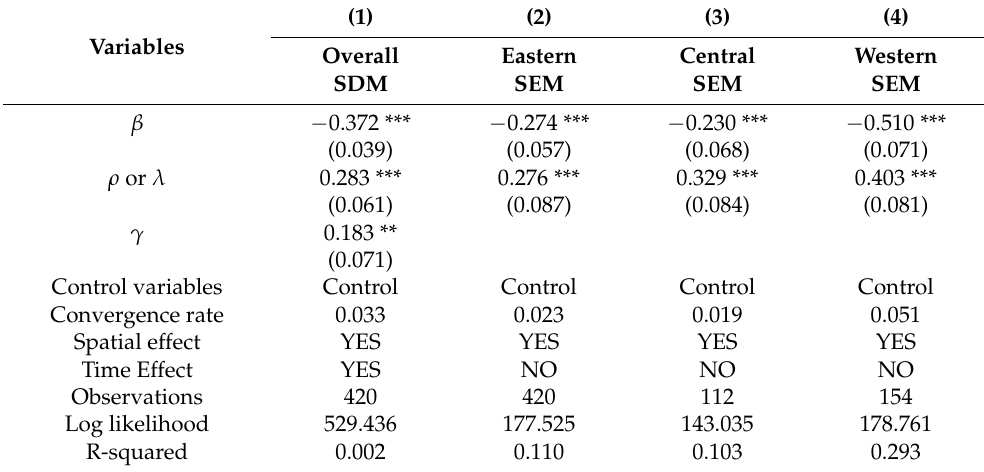
Table 7. Conditional β convergence of the livelihood resilience of rural residents in China by